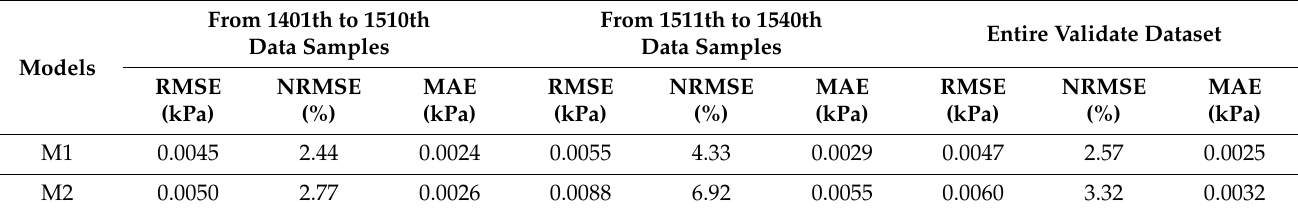
Figure 6. Estimation of outlet pressure in validation dataset by using models M1 and M2. Table 3. Estimation errors of the outlet pressure in validation